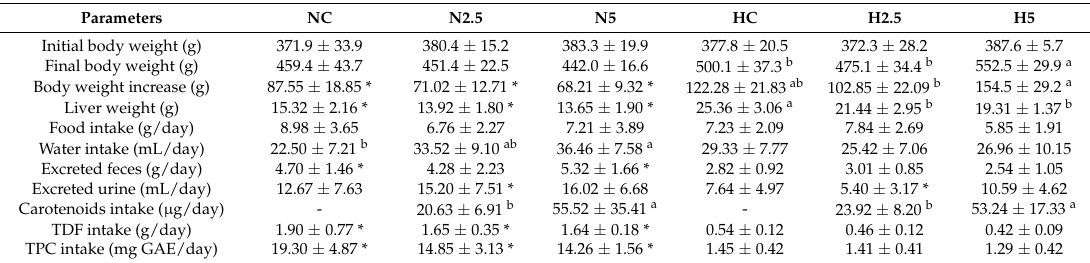
Table 2. Food and drink intake, excreted feces and urine, and carotenoid intake of the six experimental groups in the 5-week intervention period 1